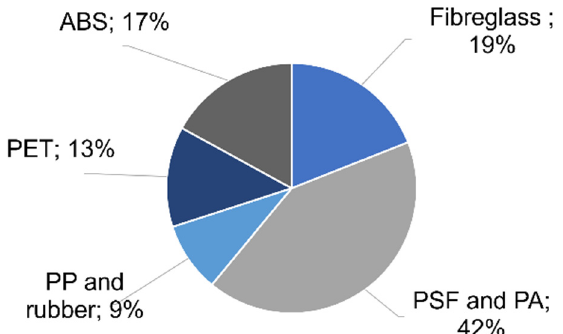
Figure 2. Composition (in percentage by weight) of a conventional 8” RO module. ABS, acrylonitrile butadiene styrene; PET, polyester; PP, polypropylene; PSF, polysulfone; PA, polyamide, rubber, and fibreglass.